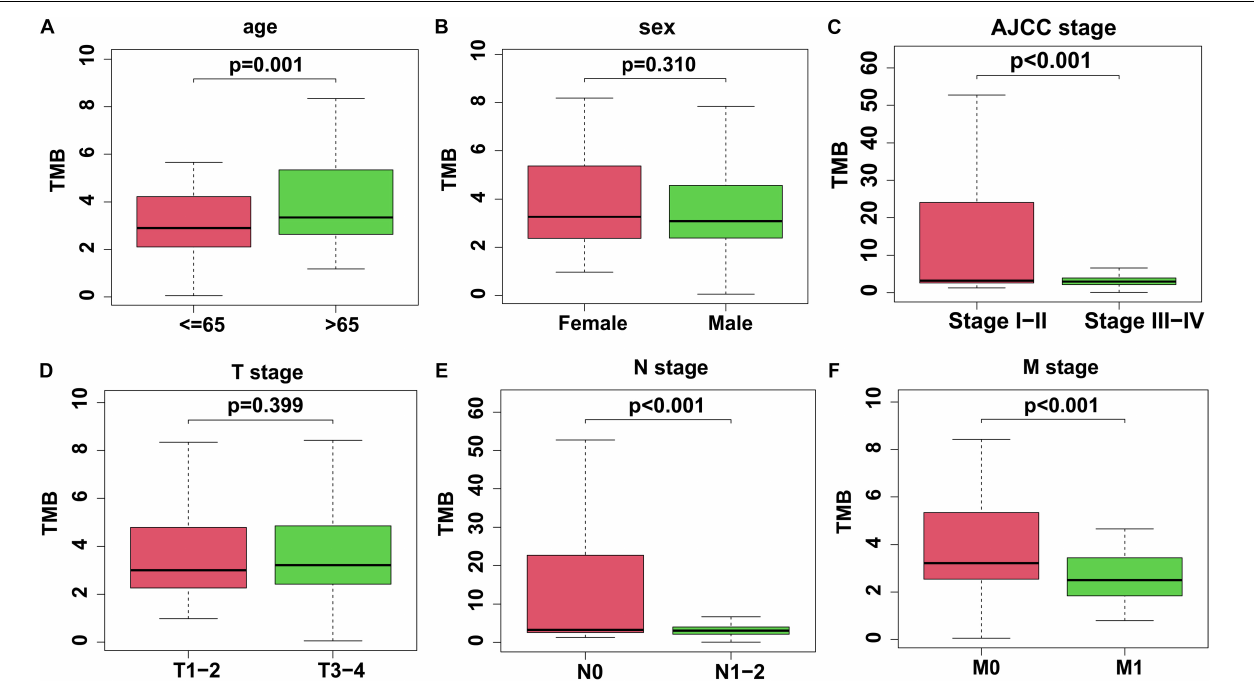
FIGURE 3 | The association between TMB and clinicopathological factors. (A) Elderly colon cancer patients > 65 years old exhibited a higher TMB level. (B) There was no significant difference of TMB level in different genders. (C) Colon cancer patients with Stage III-IV exhibited a lower TMB level. (D) No significant difference of TMB levels in different T stages. (E,F) TMB level was lower in colon cancer patients with N1-2 stage or M1 stage. TMB, tumor mutation burden.